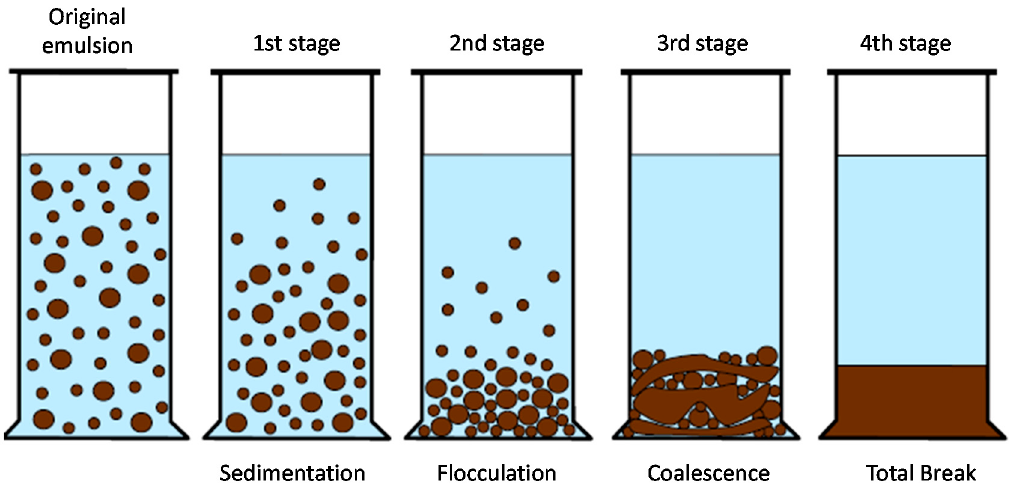
Figure 1. Storage stability evolution of an emulsion [8].